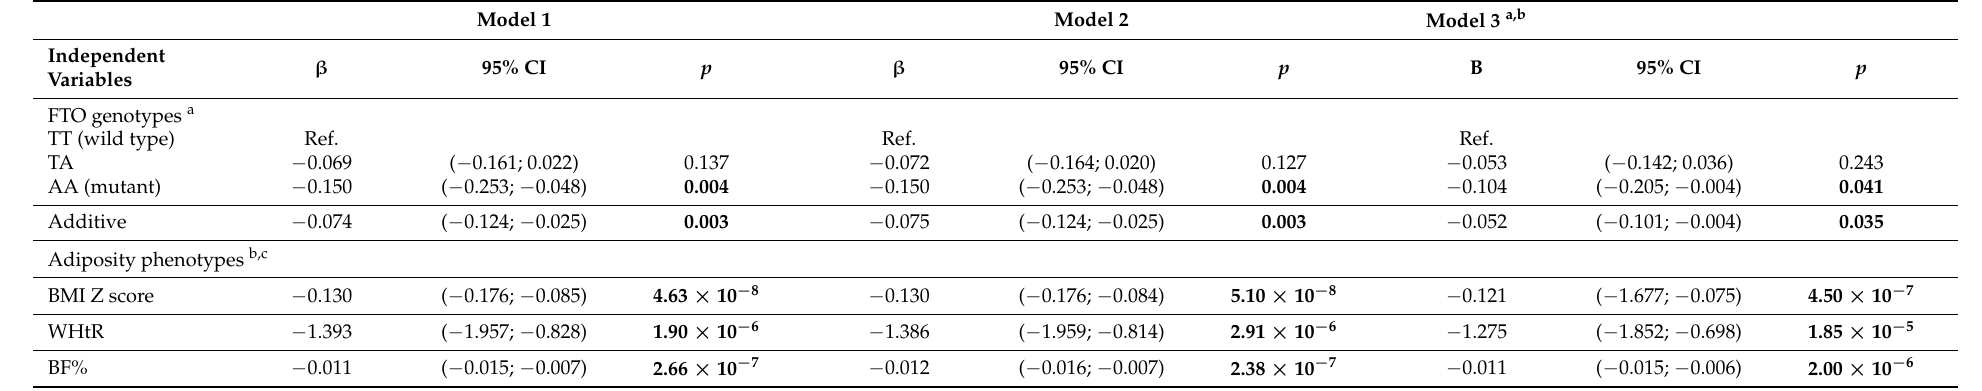
Table 2. Associations between adiponectin (log-transformed, µ g/mL) and several markers of general and central adiposity and the FTO rs9939609